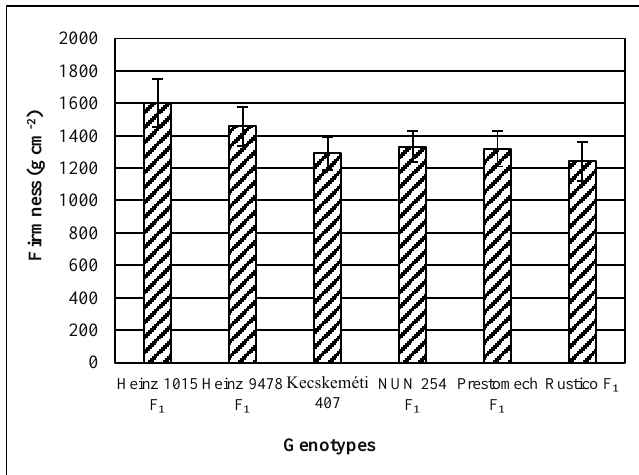
Figure 4. Evaluation of firmness by different